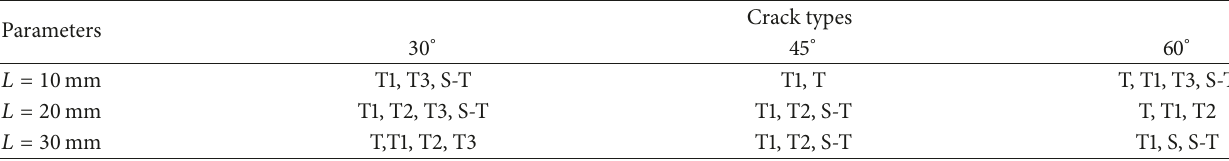
Table 5: The crack types under different